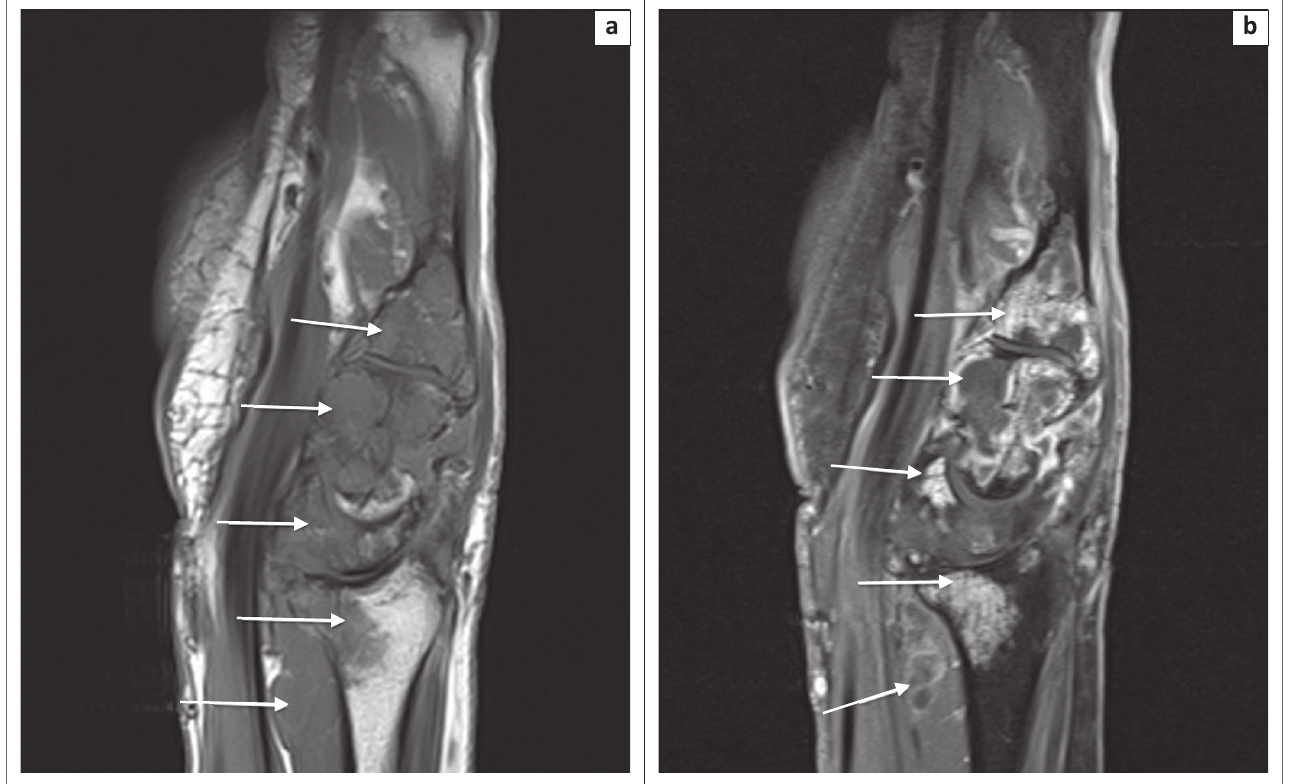
FIGURE 3: Sagittal T1 fast spin echo (FSE)-weighted images precontrast (a) and post contrast (b) demonstrate the pronator quadratus component and the intraosseous erosions in the radius, carpal bones and bases of the metacarpal bones. There is peripheral enhancement of the pronator mass, and intense solid and peripheral enhancement of the osseous erosions (white